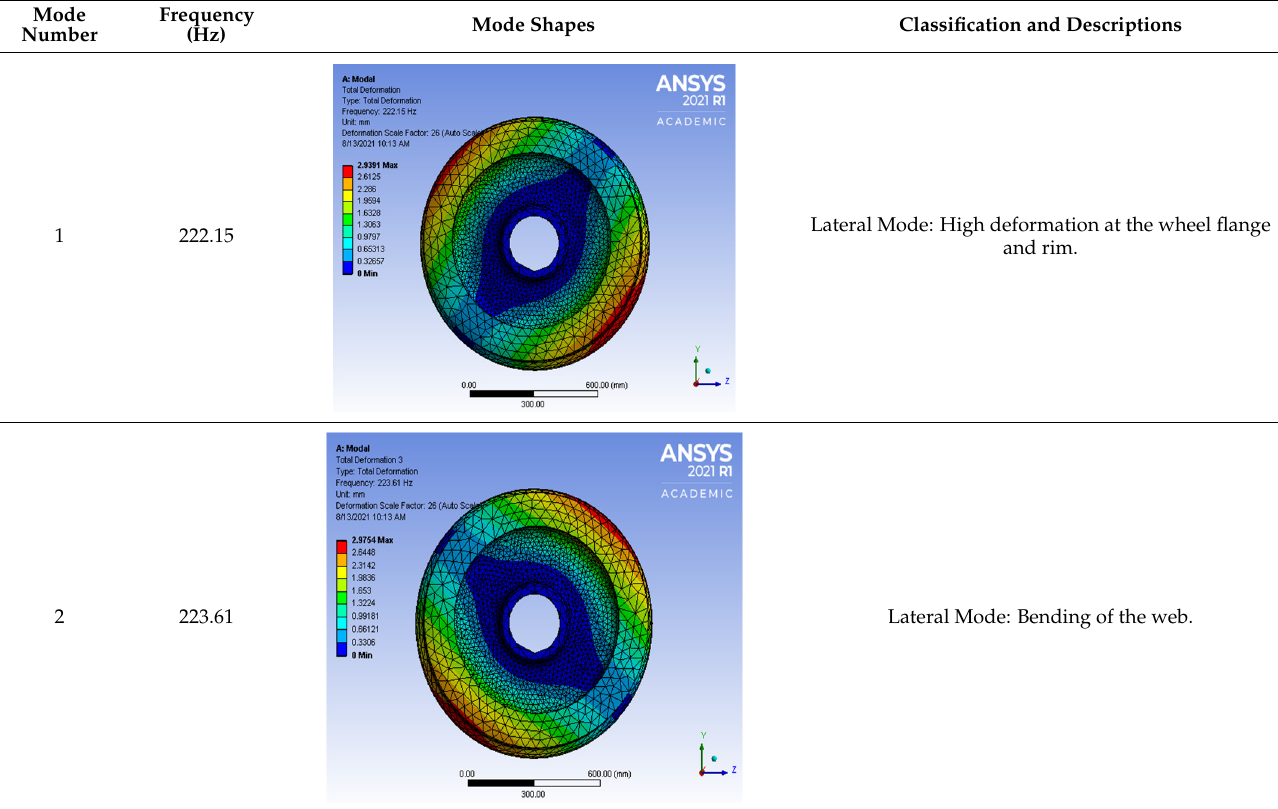
Table 7. First natural frequencies of the